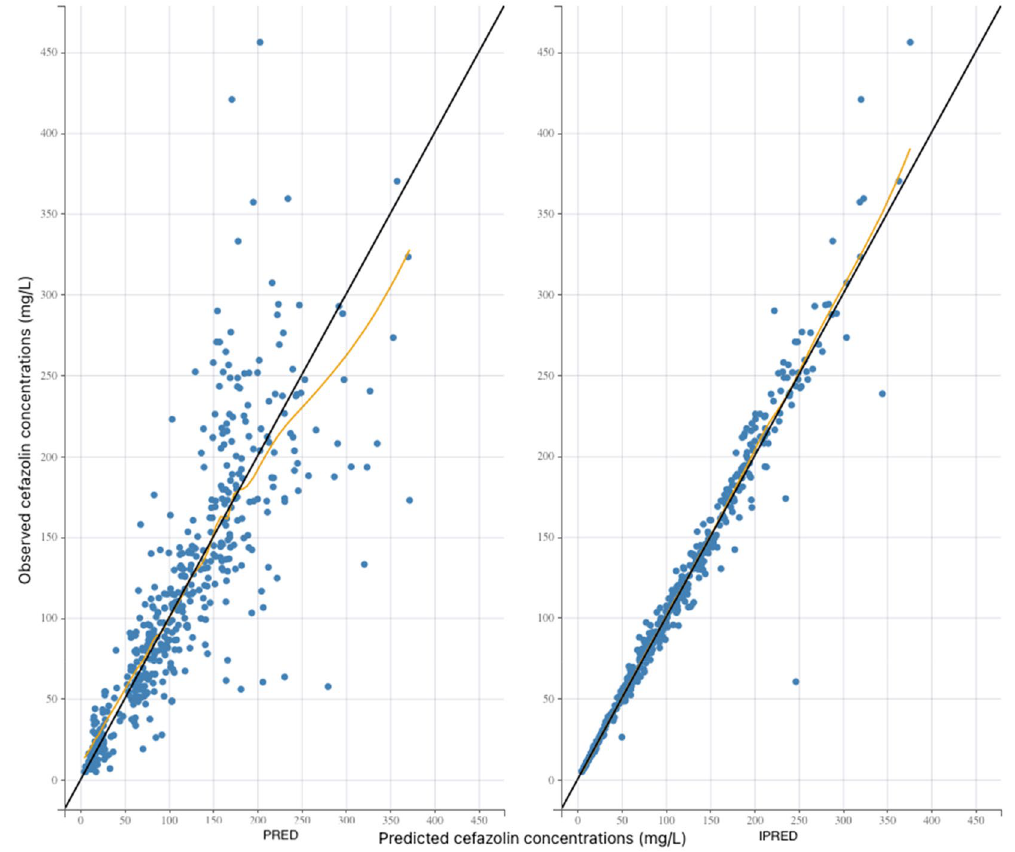
Figure 2. Goodness of fit plots. The black line represents the identity line. Blue circles represent the observed concentrations versus the corresponding predicted concentrations. The yellow line represents the trend line. Left panel: plot of the observed plasma concentrations (mg/L) versus population predicted plasma concentrations (PRED) (no random component). Right panel: plot of the observed plasma concentrations (mg/L) versus individual predicted plasma concentration values (IPRED) (with random